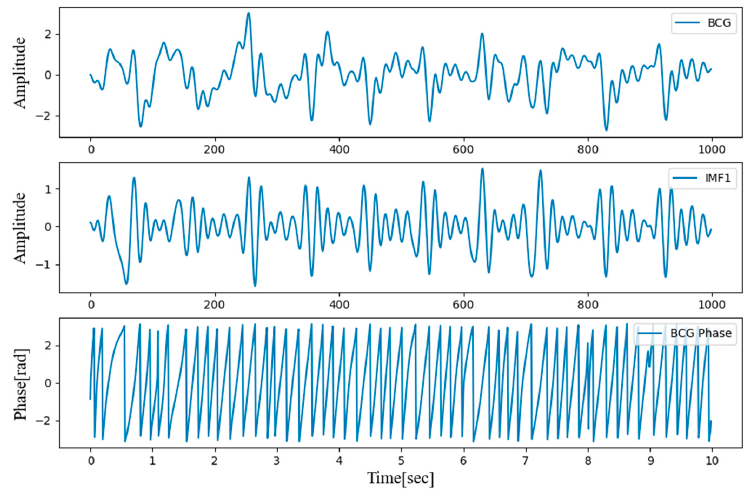
Figure 3. Filtered BCG signal, first intrinsic mode function (IMF) extracted using the empirical mode decomposition (EMD) algorithm, and BCG phase calculated by Hilbert Transform. decomposition (EMD) algorithm, and BCG phase calculated by Hilbert